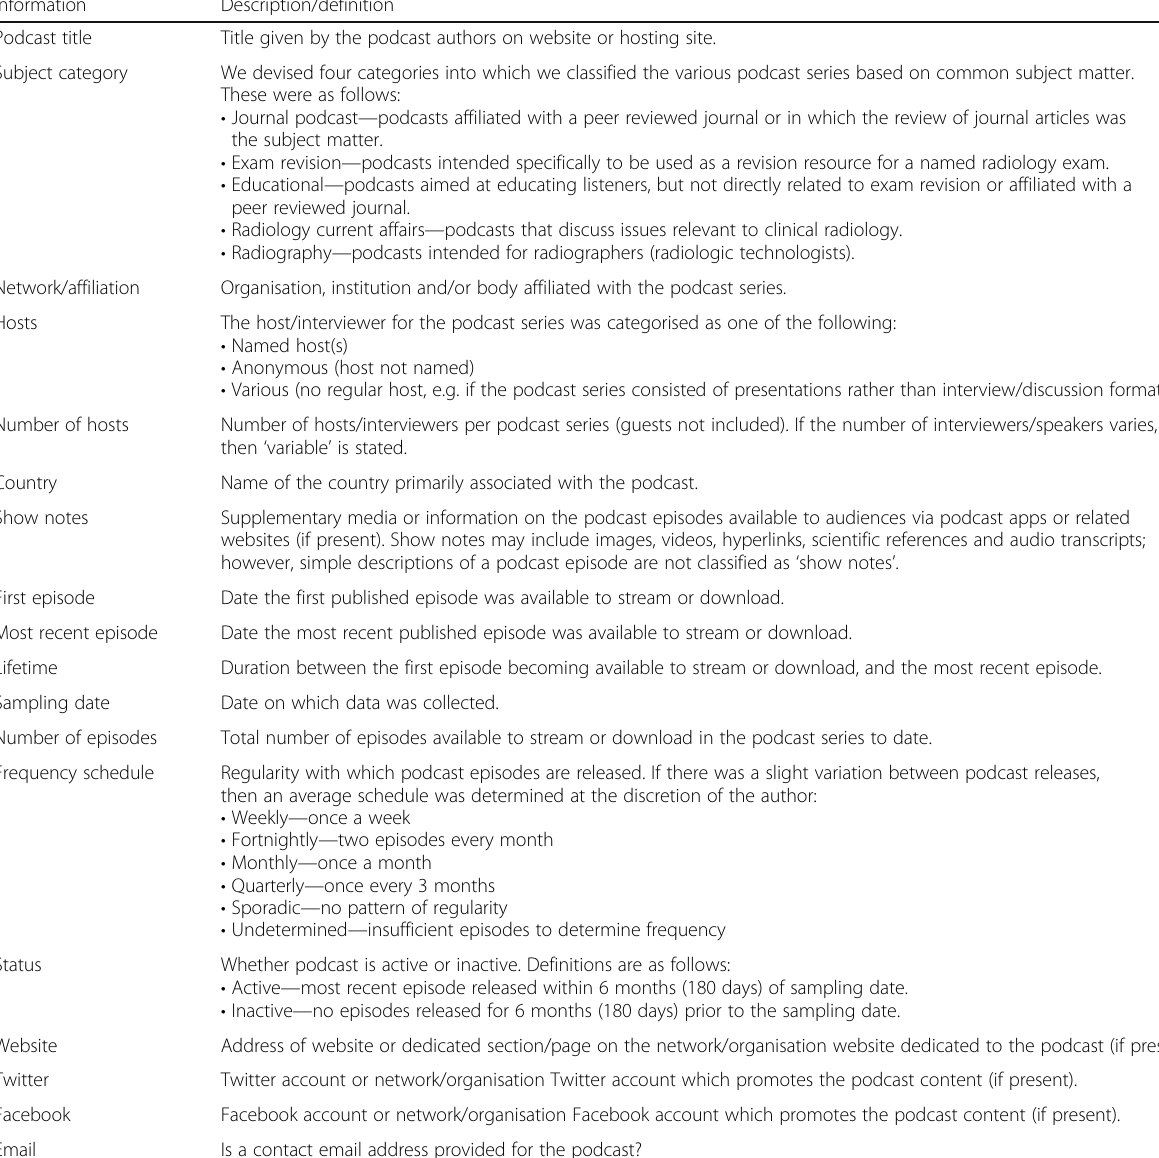
Table 2 Information collected for each podcast series along with